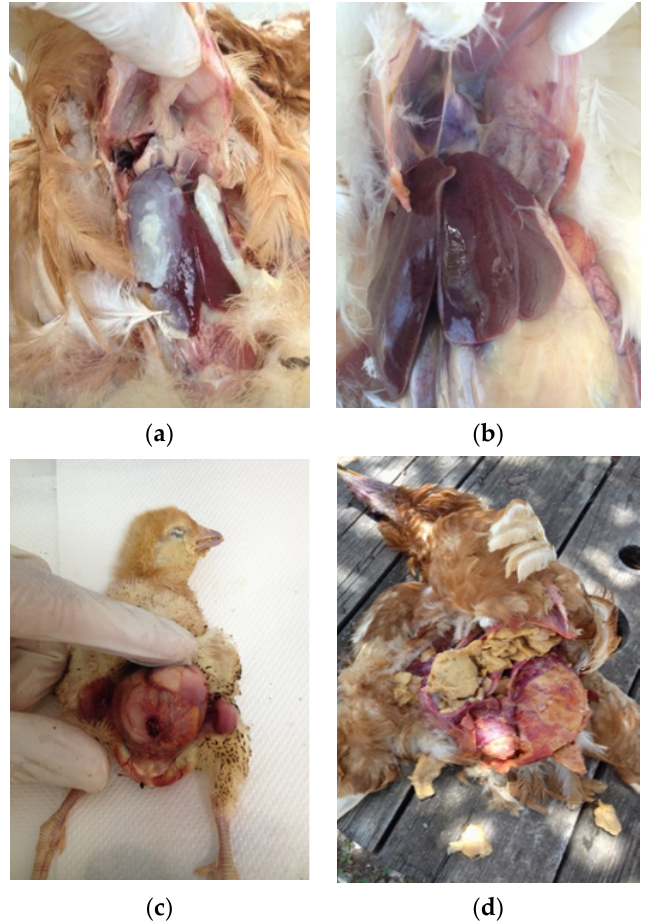
Figure 1. Macroscopic lesions indicating colibacillosis: ( a ) perihepatitis/pericarditis; ( b ) air sacculitis; ( c ) omphalitis;( d ) peritonitis.